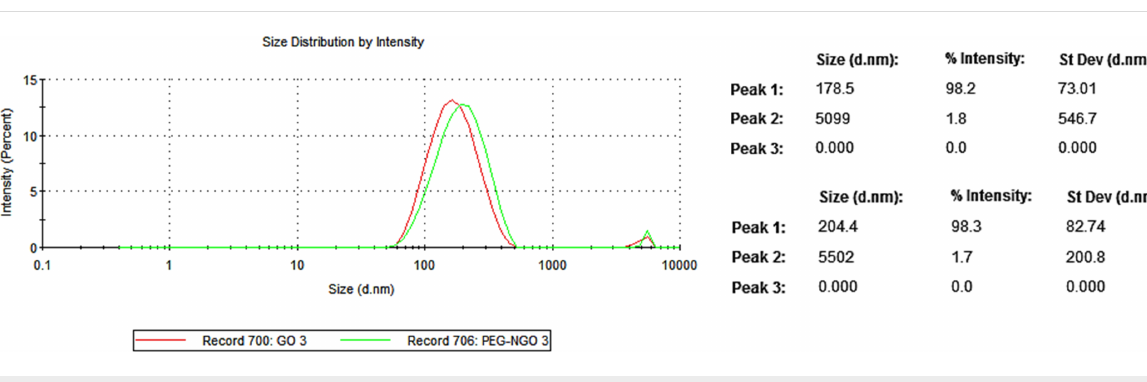
was still significantly increased ( P * < 0.05) in brain, heart, and